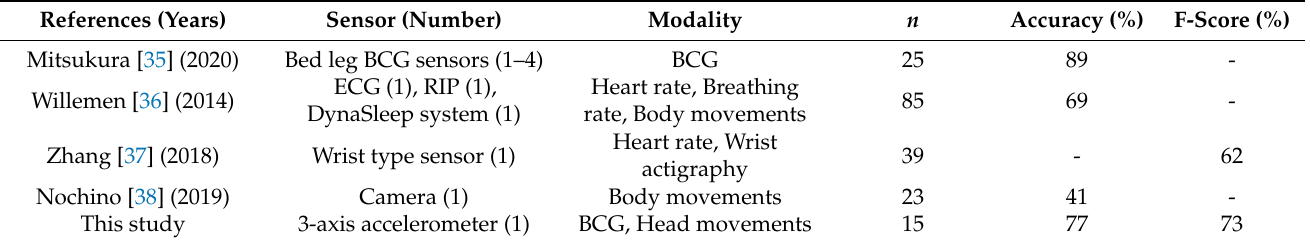
Table 6. Performance of sleep stage classification in related works for